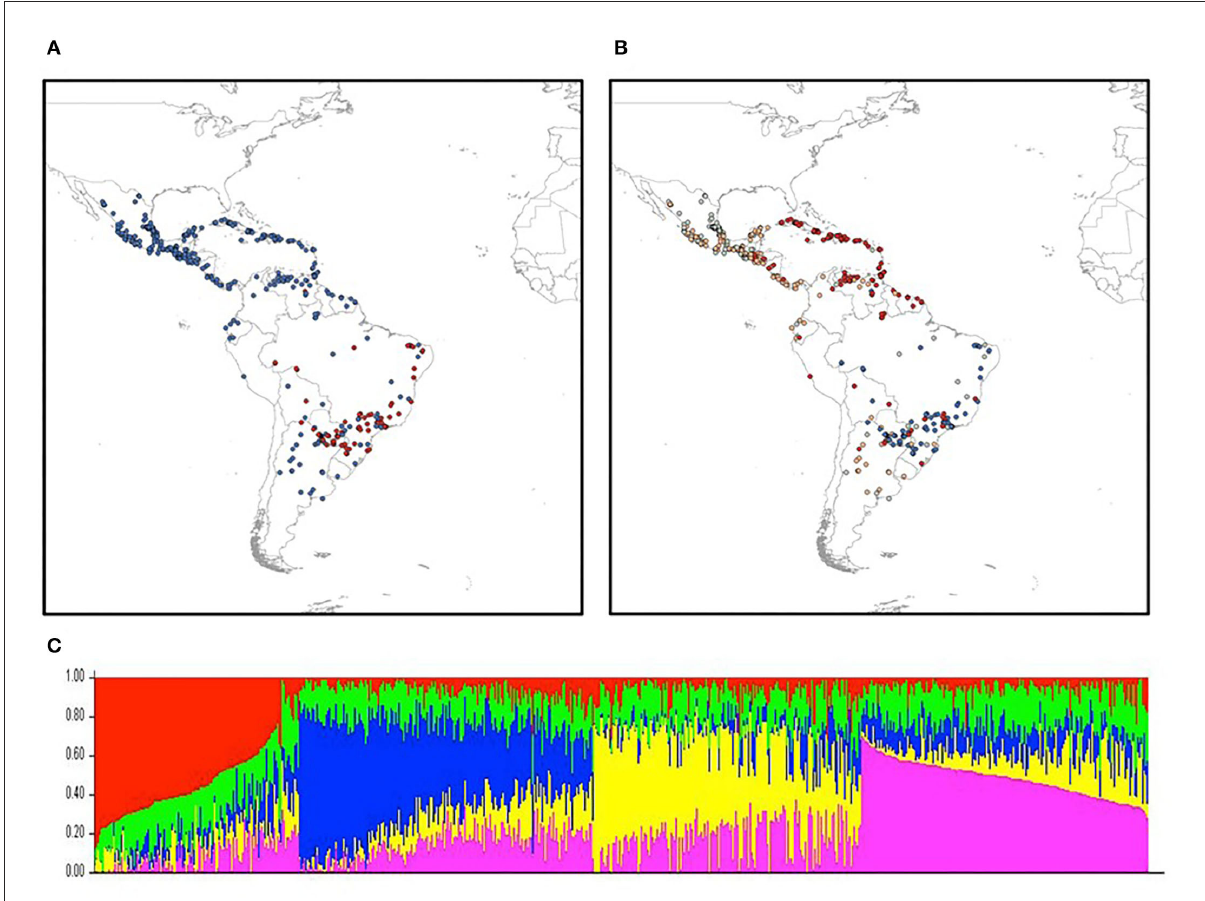
FIGURE4 Spatial principal component and STRUCTURE analyses of maize landrace accessions of TSC GWAS panel. (A) Distinct genetic composition of Brazilian accessions (red dots) in TSC panel by the first principal component (PC). (B) Genetic clustering of lowland, highland Mexican, and Caribbean accessions by four PCs. (C) Distinct genetic structure between highland (red), lowland (blue), mid-attitude (yellow) Mexican accessions, and Caribbean ones (pink) of TSC GWAS